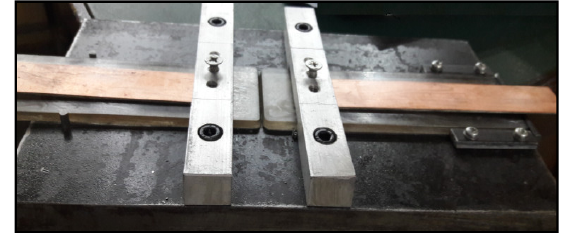
Fig. 4: Fixture for Clamping PC Plates